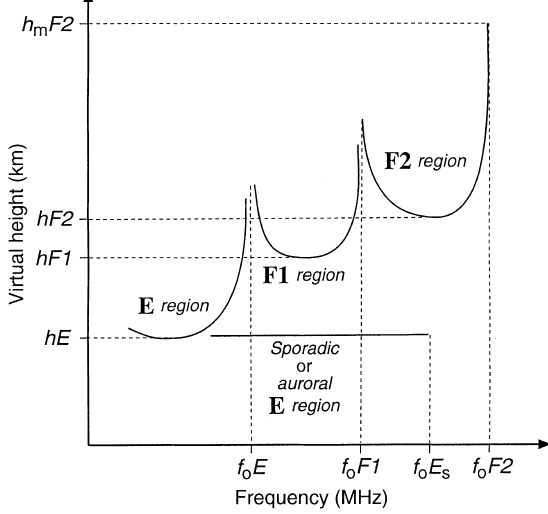
Fig. 4. A schematic representation of a summer or equinox daytime ionogram, indicating the parameters scaled from the Tromsø